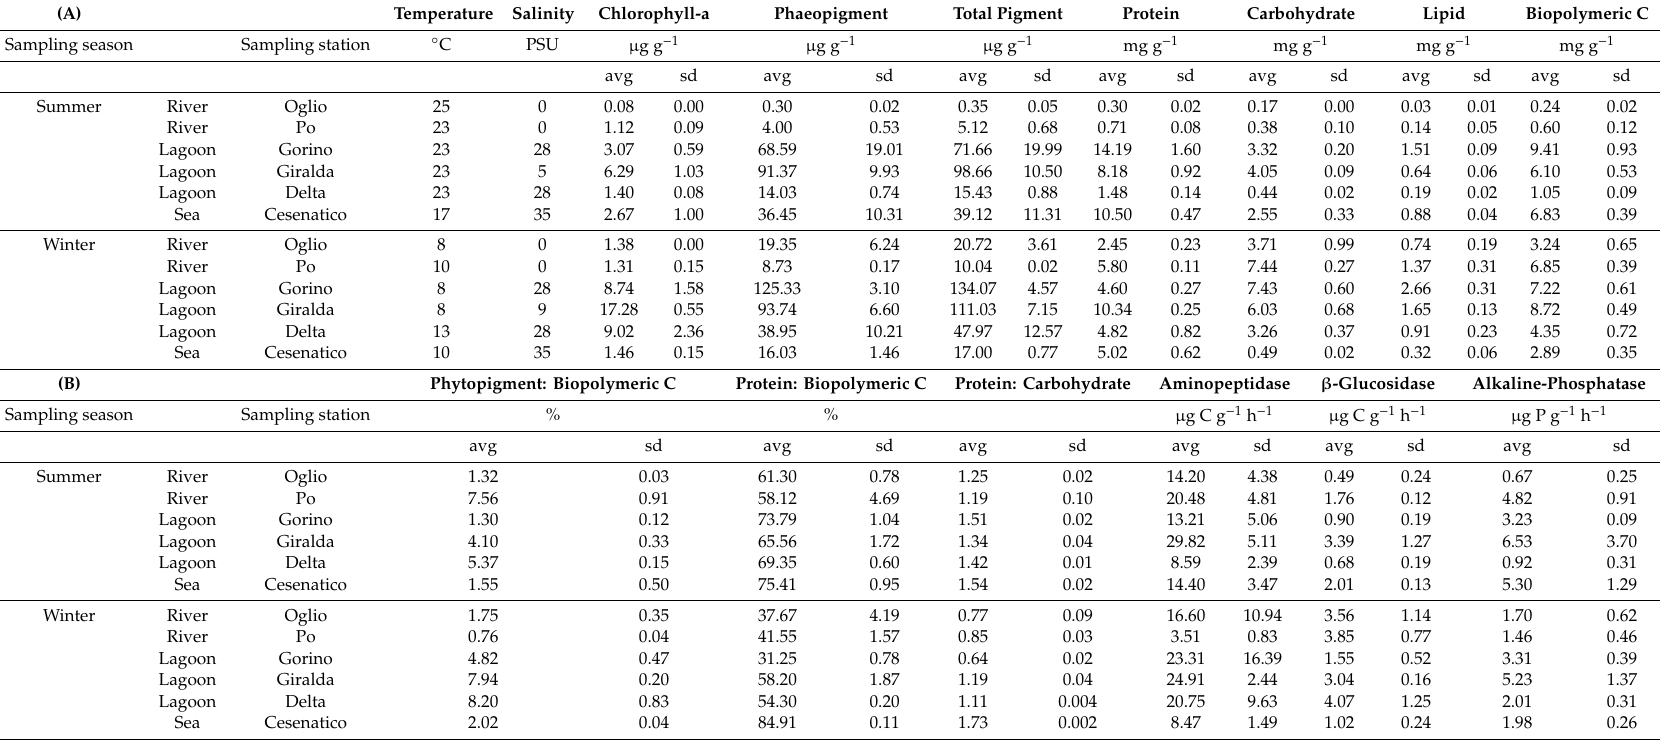
Table 1. Temperature, salinity, organic matter contents ( A ), descriptors of organic matter nutritional quality, and degradation rates ( B ) in the sediments of the investigated stations across the river-to-sea transect in summer and